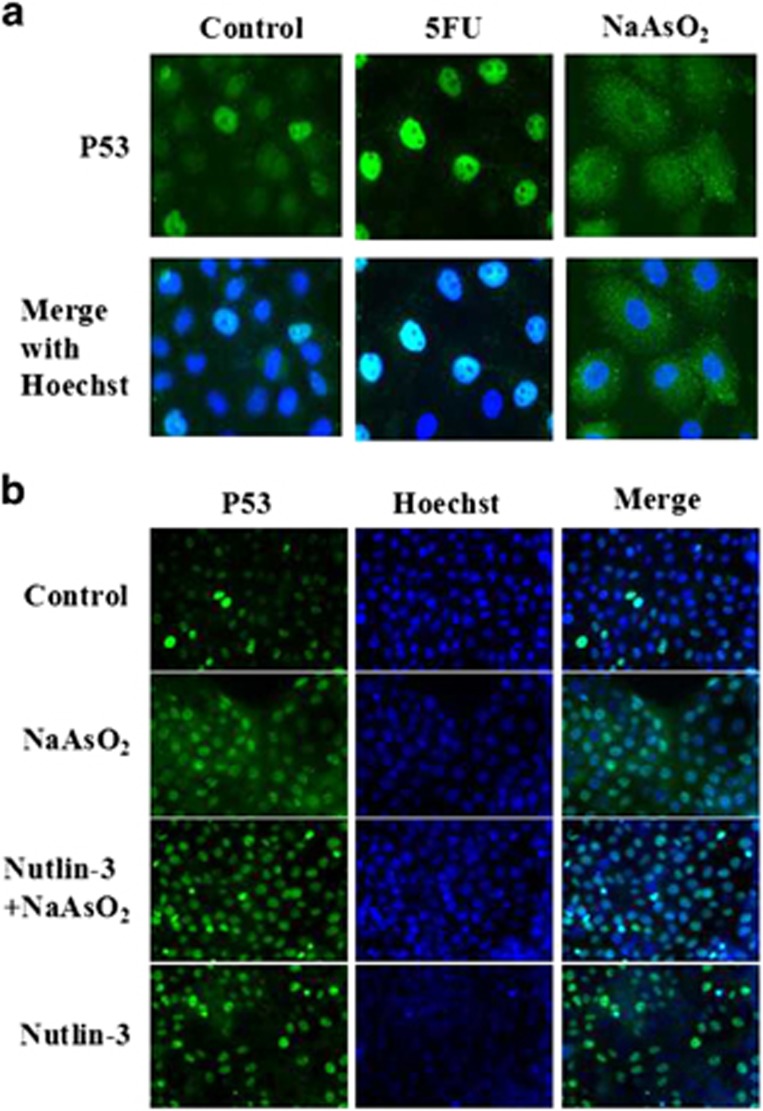
Subcellular localization of p53 detected by immnofluorescence. (a) Cells treated with 5-FU had localization of p53 primarily in the nucleus, while cells pretreated with sodium arsenite exhibited primarily cytoplasmic localization of p53. (b) After addition of Nutlin-3 to block the interaction between p53 and MDM2, p53 was mainly found in the nuclei of keratinocytes, regardless of whether the cells were treated with 5-FU or sodium arsenite.